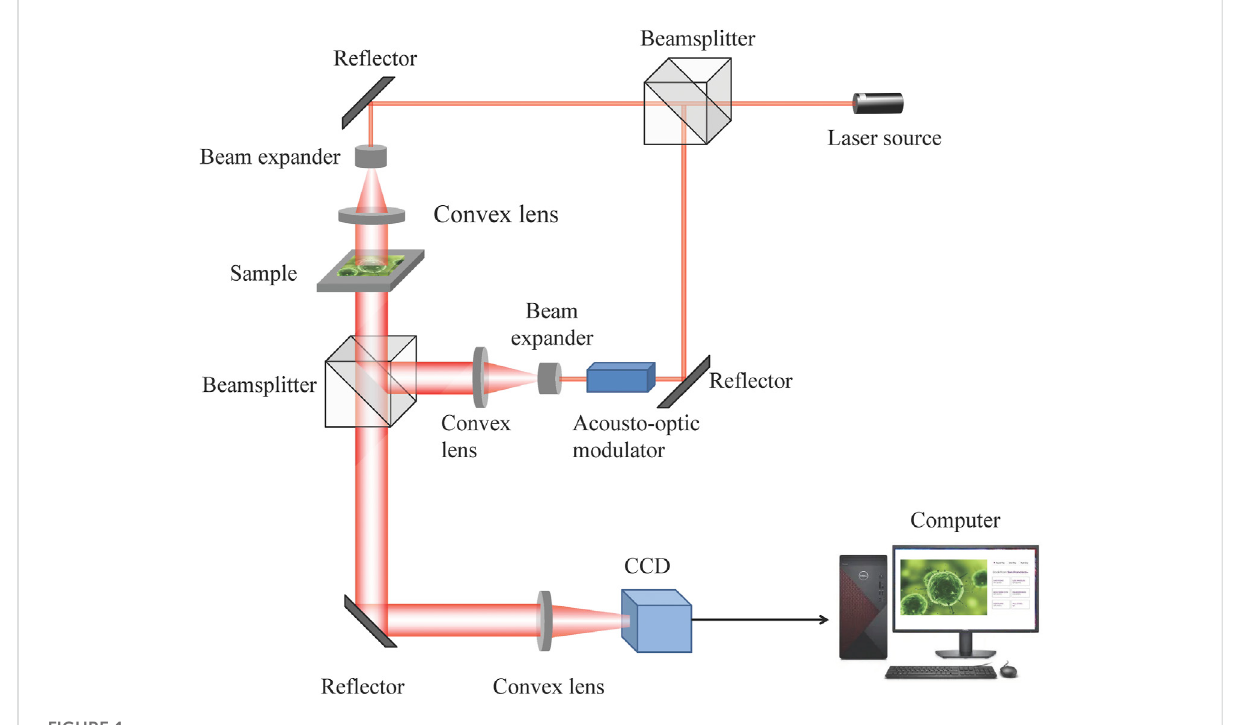
FIGURE 1 General setup of the holographic imaging measurement